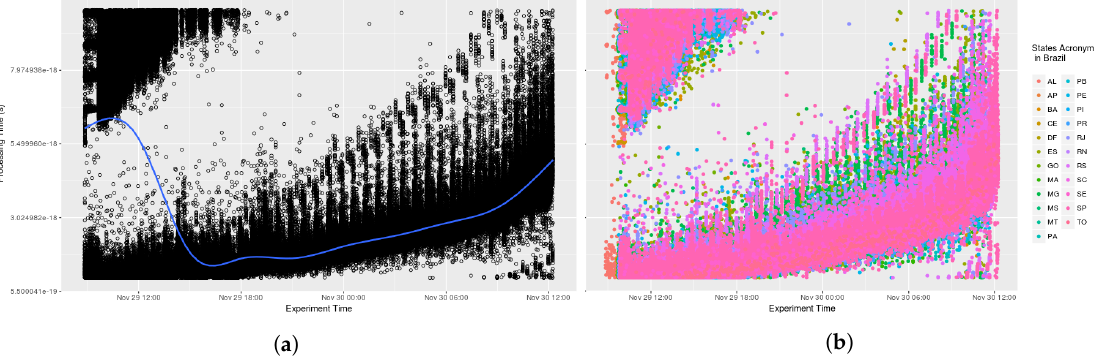
Figure 9. Scenario 01—Processing Time. ( a ) Stations in the whole country of Brazil; ( b ) Stations grouped by states.